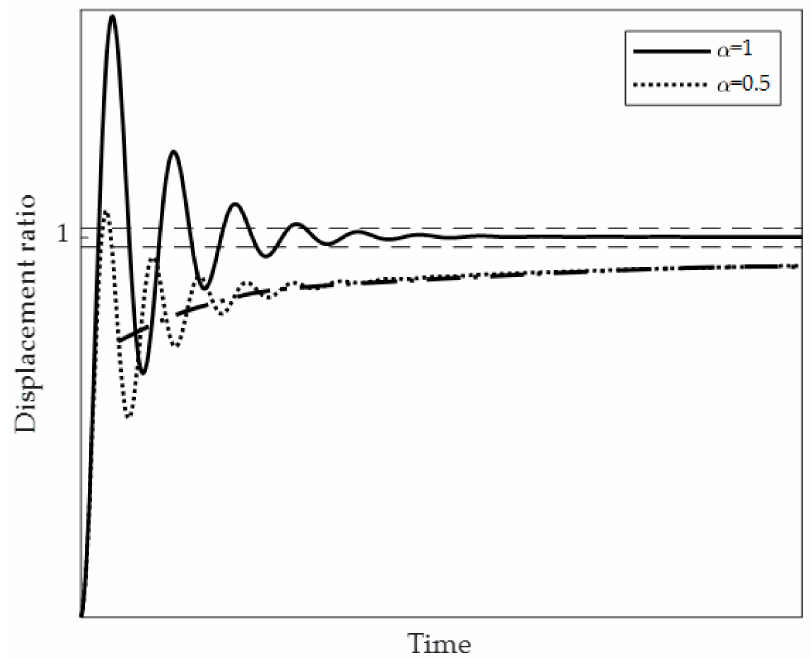
Mathematics 2021 , 9 , x FOR PEER REVIEW 21 of 27 Figure 7. Comparison between viscous and viscoelastic behaviors. Continuous line ( α = 1) corre- sponds to viscous response and dotted line ( α = 0.5 ) to viscoelastic response. The line ( ) represents point of equilibrium changing over time and the two horizontal dashed lines ( ) represent the ± 2.5% interval of the stationary